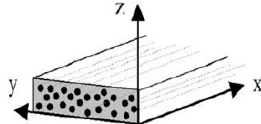
Figure 6. Coordinate system associated to an unidirectional composite [31].